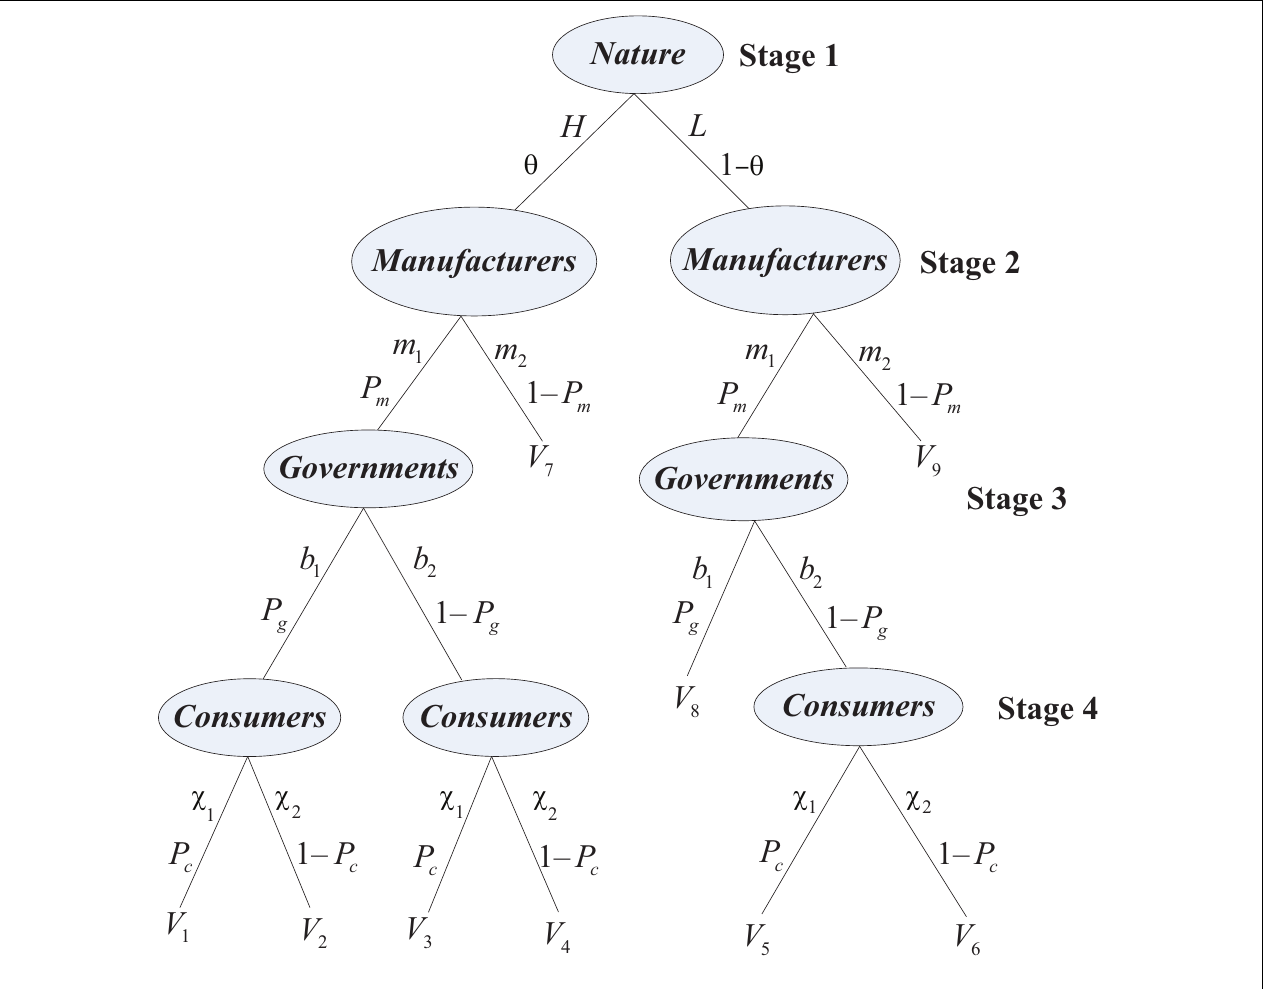
FIGURE 2 | Bayesian game among governments, manufacturers, and consumers.